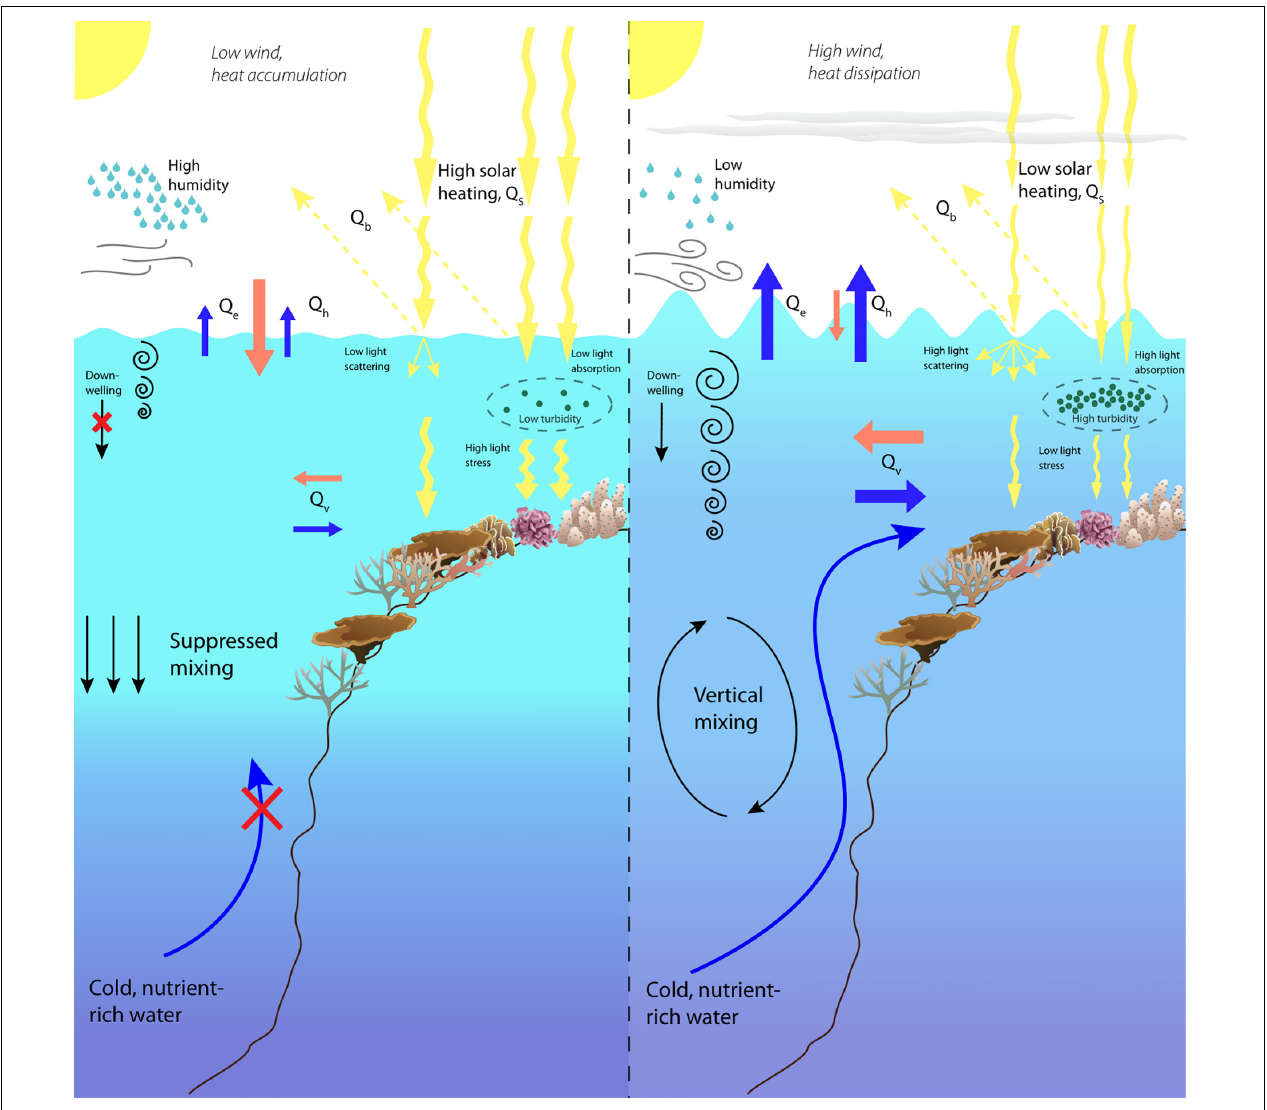
FIGURE 1 | Conceptual diagram illustrating the confluence of environmental conditions that drive the rapid and intense heating in reef environments. Coral colony graphics courtesy of the Integration and Application Network, University of Maryland Center for Environmental Science.